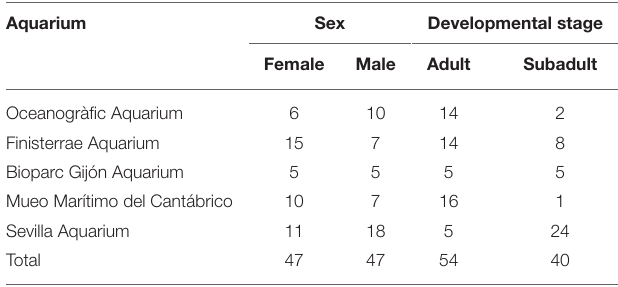
TABLE 1 | Classification of Nursehound Shark ( Scyliorhinus stellaris ) included in this study according to sex and developmental stage. Aquarium Sex Developmental stage Female Male Adult Subadult Oceanogràfic